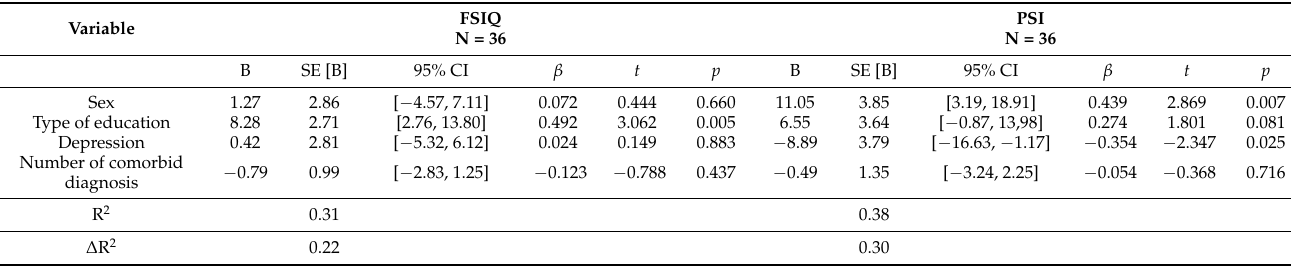
Table 4. Regression coefficients for predicting the FSIQ and the